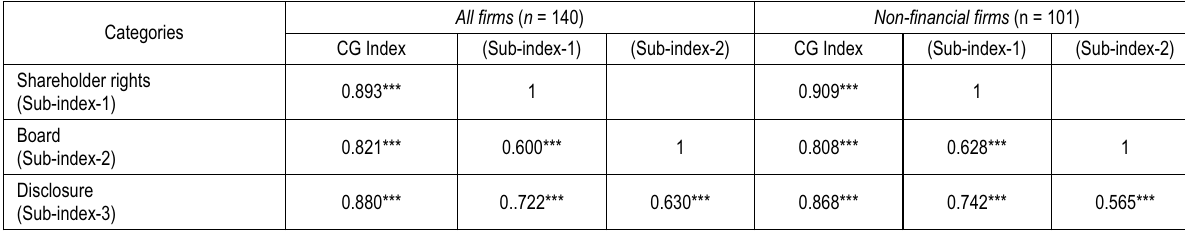
Table 2. Correlation matrix for corporate governance index and